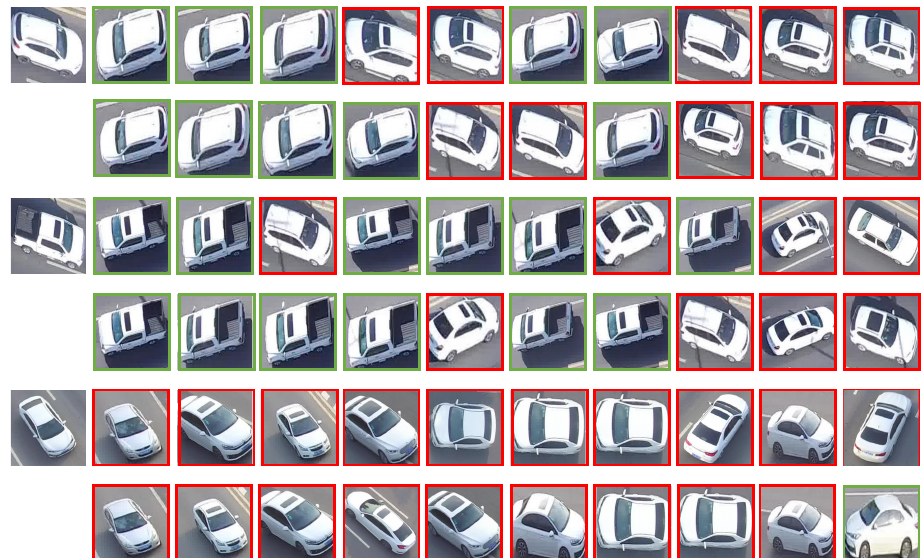
Figure 15. Visualization results on VRAI dataset. For each query, the first line shows the results of baseline and the second line of our method. True positive results are in green boxes while false positive results in